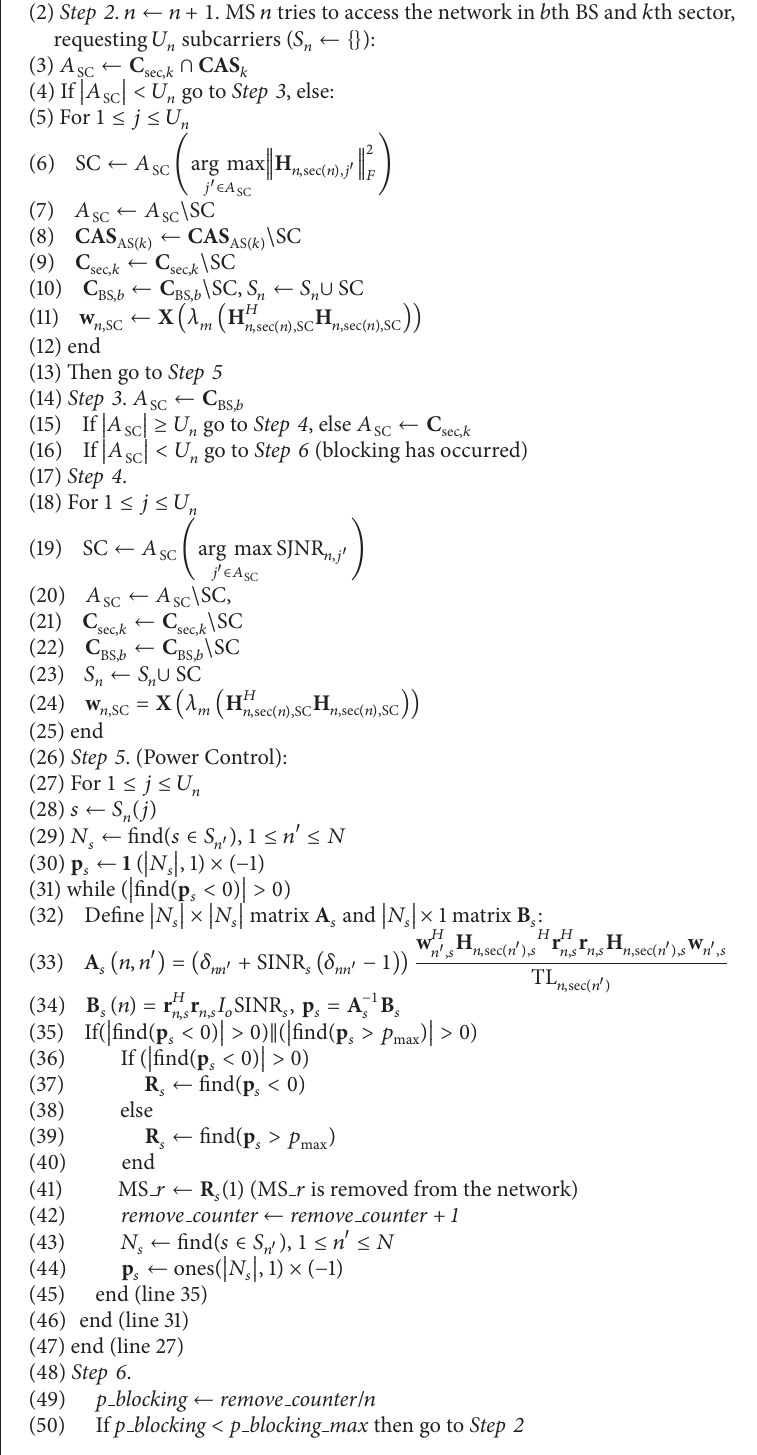
Algorithm 1: The proposed subcarrier allocation